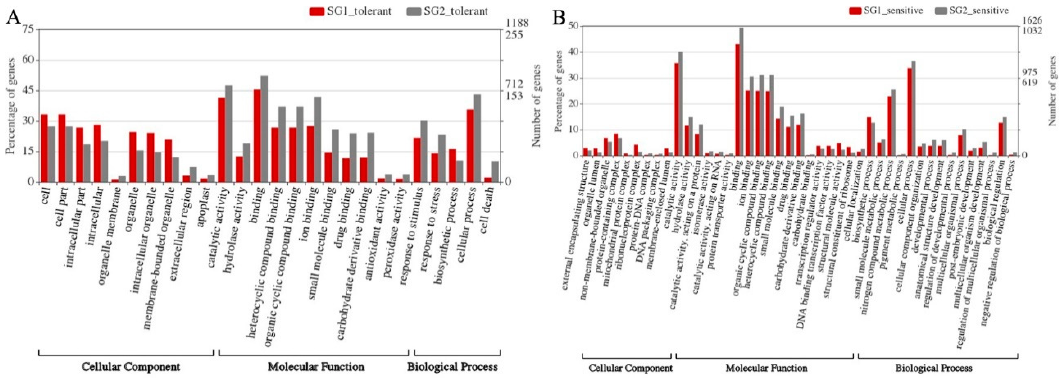
Figure 5. Gene ontology (GO) plot on genes with different expression patterns. ( A ). Genes with different expression patterns between Indica Al-tolerant and Japonica Al-tolerant sub-species; ( B ). Genes with different expression patterns between Indica Al-sensitive and Japonica Al-sensitive. SG1 and SG2 represent Indica and Japonica , respectively.